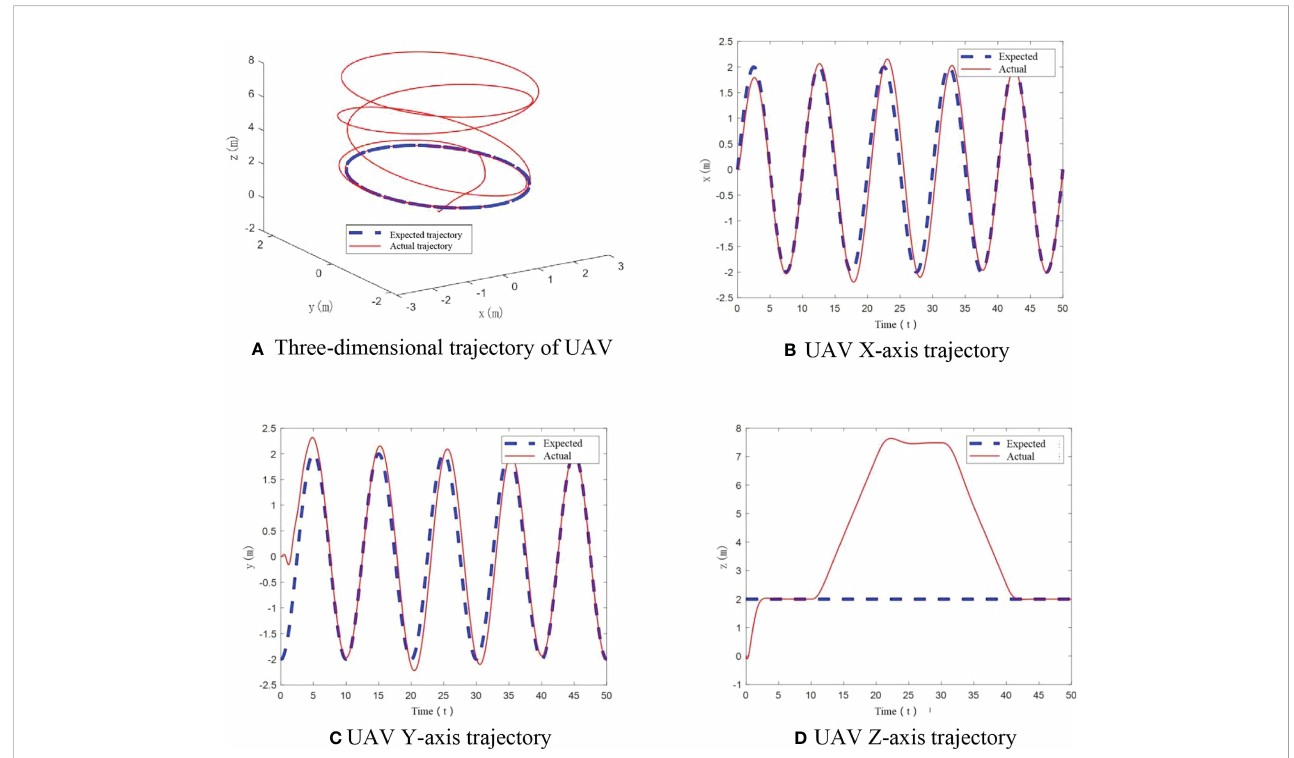
FIGURE 14 UAV fl ight trajectory with mass change. (A) Three-dimensional trajectory of UAV, (B) UAV X-axis trajectory, (C) UAV Y-axis trajectory, (D) UAV Z-axis